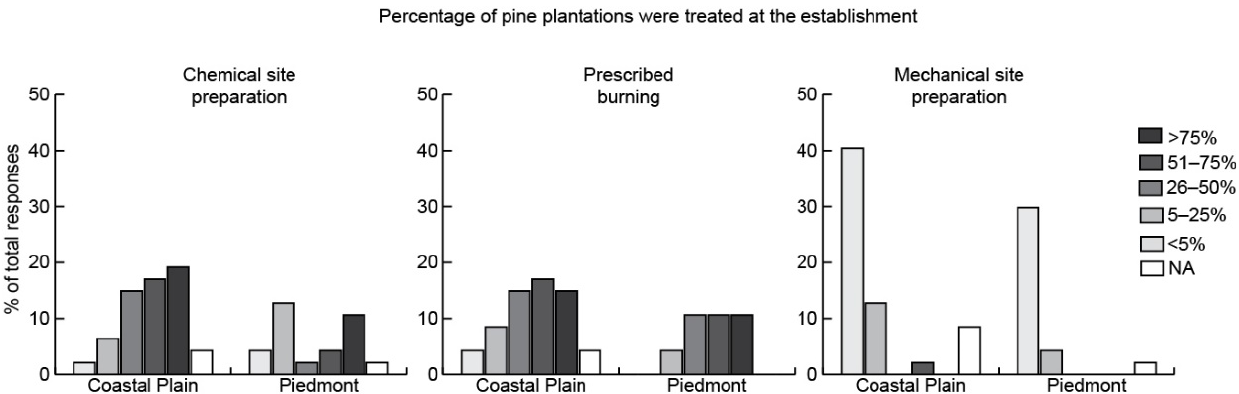
Figure 2. The survey respondents’ reported site preparation practices conducted in pine stands in Georgia.